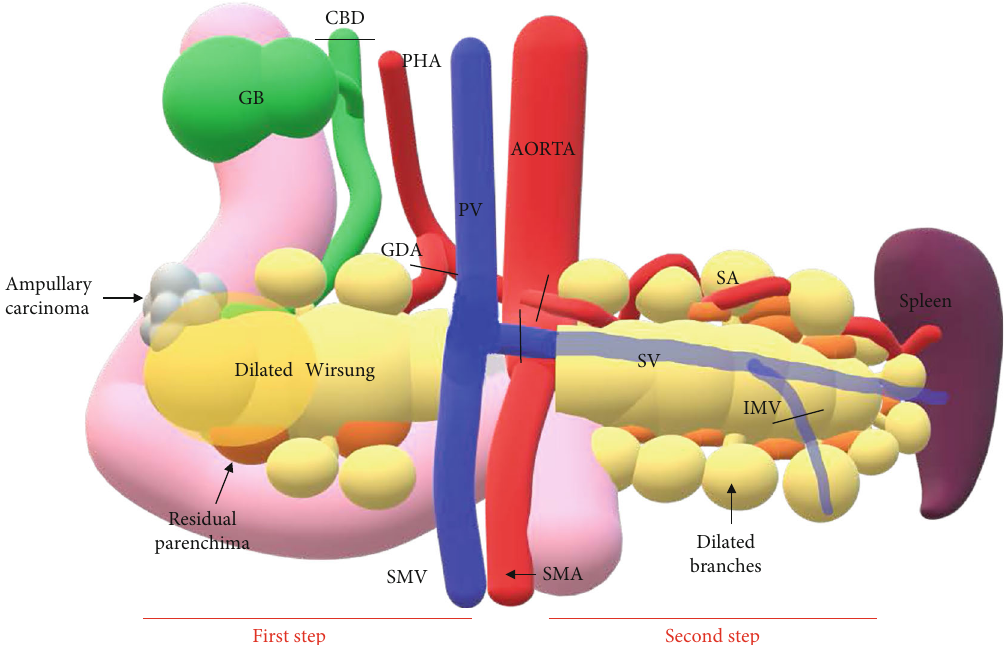
Figure 3: Schematic representation of the two-step procedure. GDA: gastroduodenal artery; CBD: common bile duct; GB: gallbladder; IMV: inferior mesenteric vein; PHA: proper hepatic artery; PV: portal vein; SV: splenic vein; SA: splenic artery; SMV: superior mesenteric vein; SMA: superior mesenteric artery.